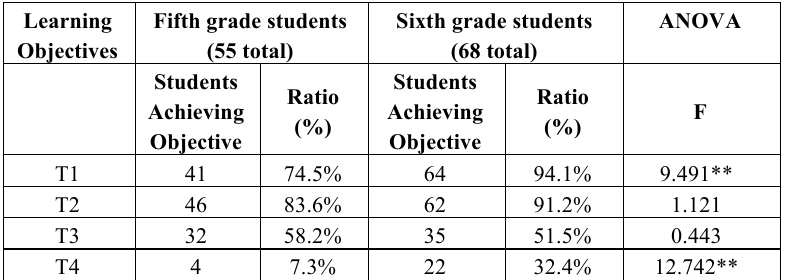
Table 4. Performance according to age (fifth grade: age 10, sixth grade: age 11, **p<0.01) Learning